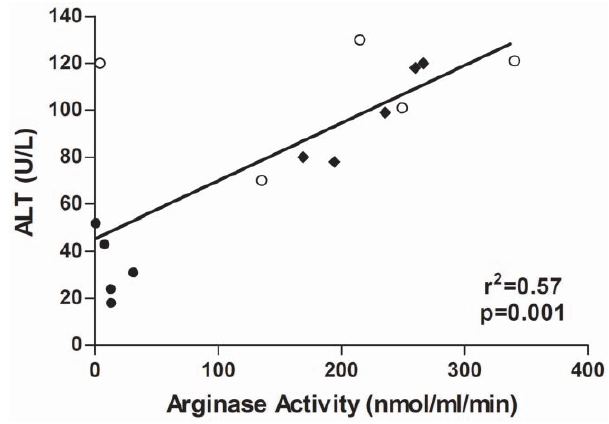
Figure 4. Correlation between activities of ALT and arginase in plasma of apoE 2 / 2 mice on different diets. Regression analysis of ALT and arginase activities for the different diets (n=5 in each group) is indicated by the solid line. Key to symbols: solid circles, standard diet; solid diamonds, HF diet; open circles, HC diet.